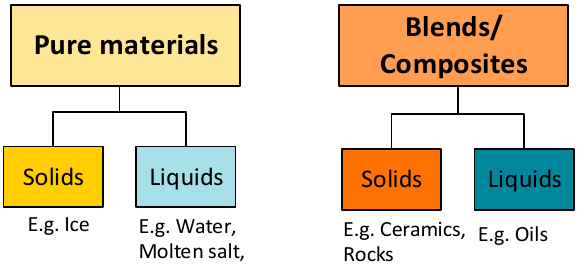
Figure 1. Basic categorization of STESMs.